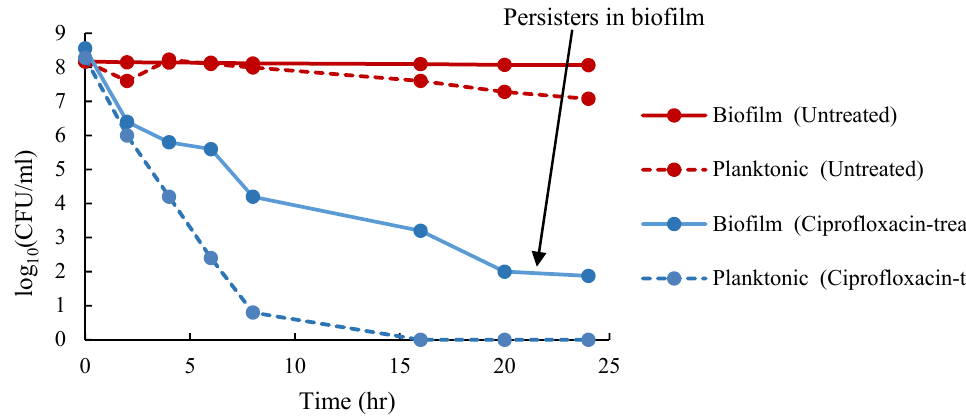
Figure 2. Detection of persisters from biofilm and planktonic cells of A. baumannii ST 1894. The number of viable biofilm and planktonic cells at different time points after treatment with 2048 μ g/mL ciprofloxacin. Red solid and dotted lines represent untreated biofilm and planktonic cells, respectively. Blue solid and dotted lines represent biofilm and planktonic cells treated with ciprofloxacin, respectively.